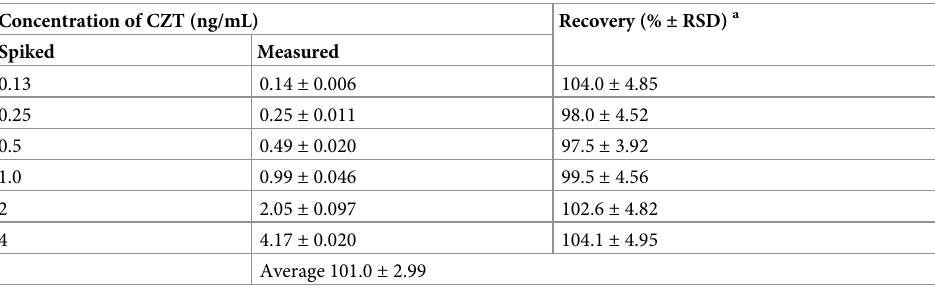
Table 5. Analytical recovery of CZT spiked in plasma